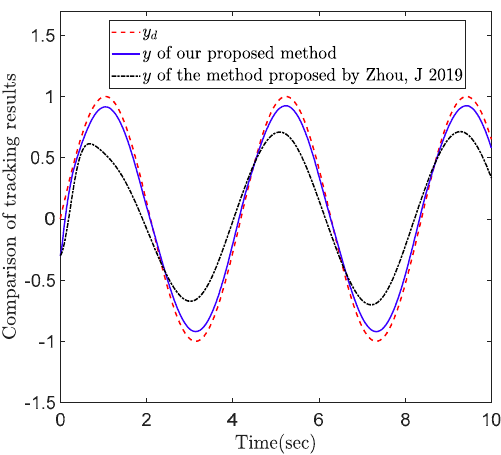
y . Figure 5. Output y of our control scheme and method in [20] and y d d